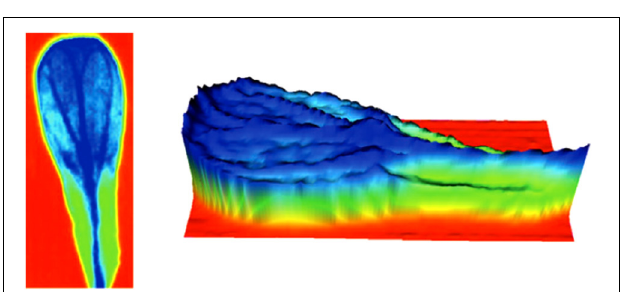
FIGURE 7 | FTIR imaging of Arabidopsis petals: absorbance maps obtained on the basis of the second derivative of spectra for esters of fatty acids at 1734cm − 1 . More negative intensities (high concentration) are indicated in dark blue. The zero level is indicated in red (adapted from (Mazurek et al., 2013), with permission of John Wiley and